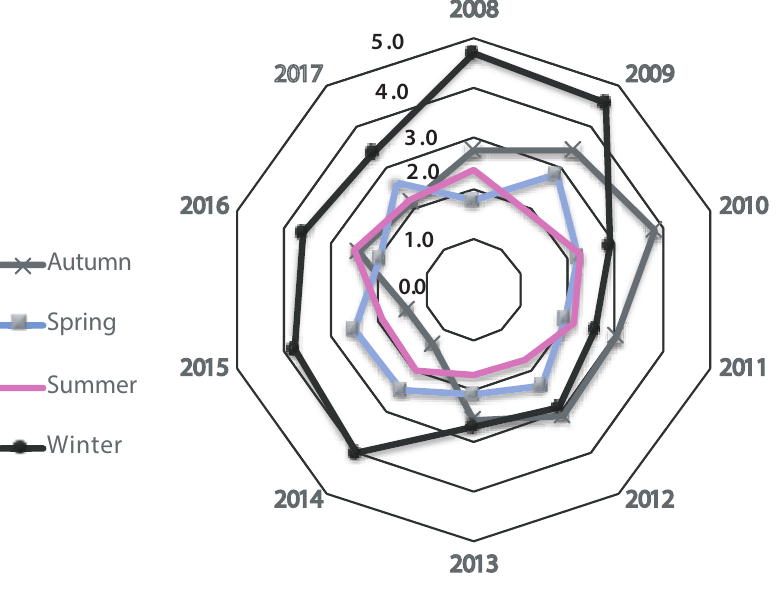
Figure 2. MAPE radar diagram of the forecasts for the NMC 24,168 model using the demand time series from 2008 to